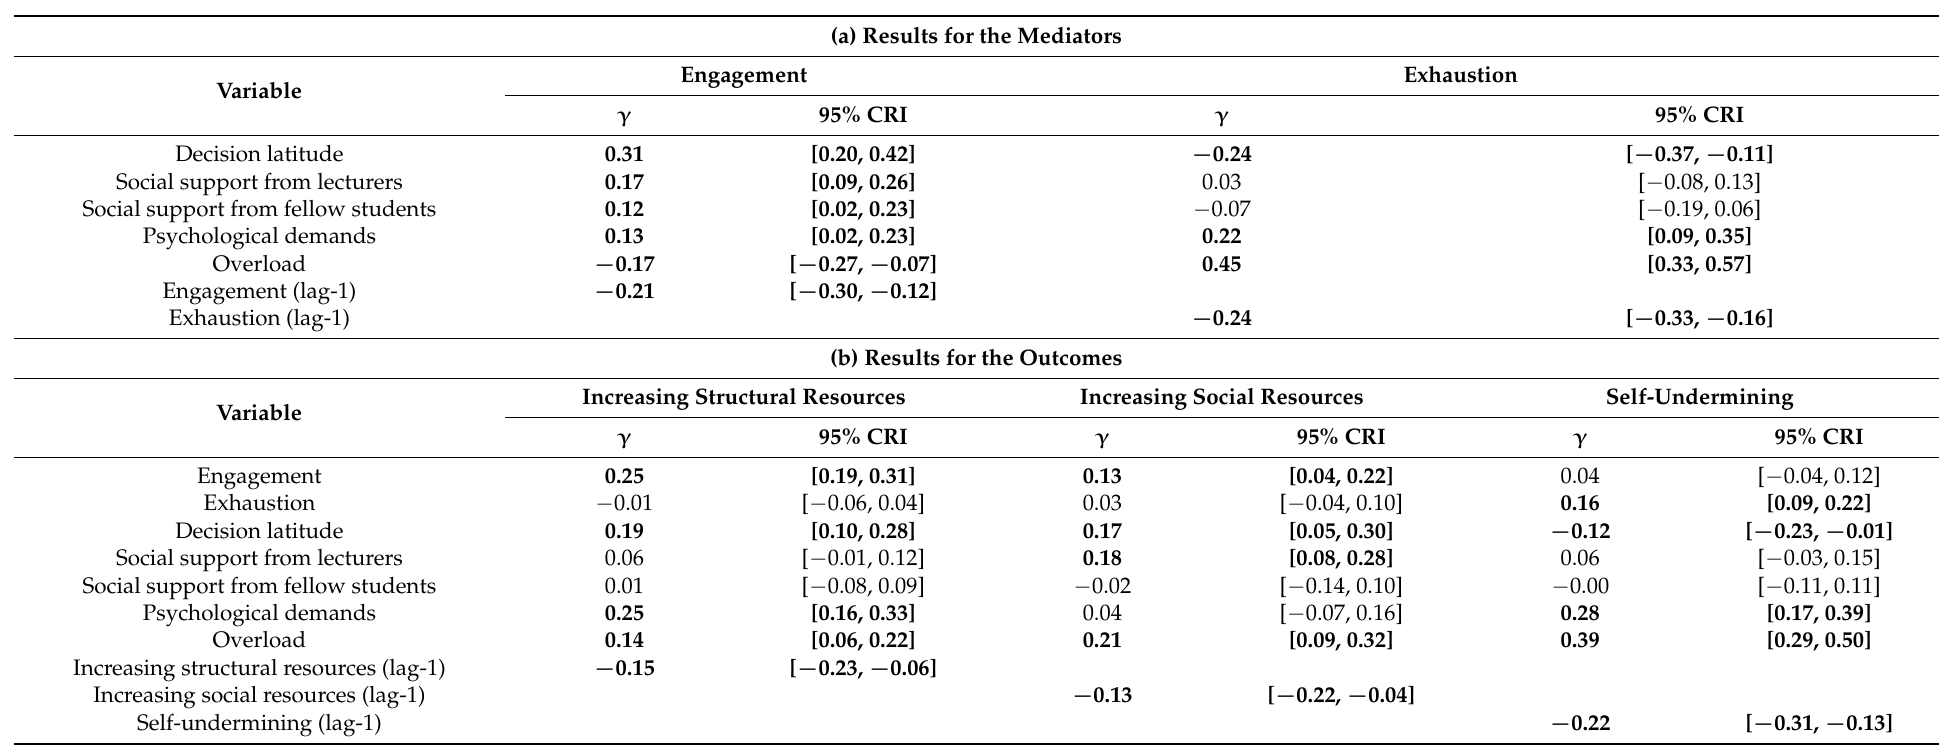
Table 3. Within-person path coefficients and credibility intervals for the mediators and the